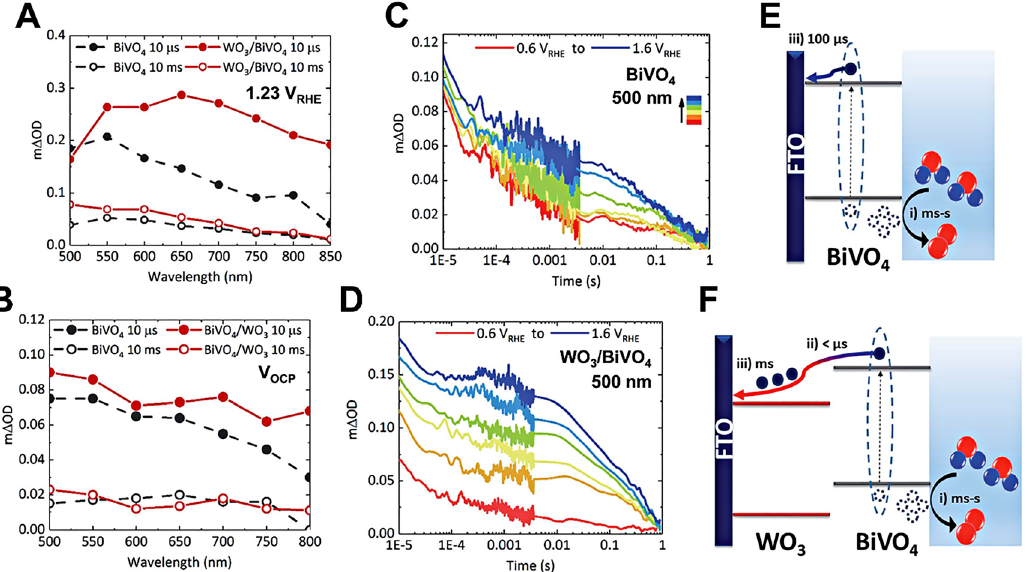
Figure 5: (A, B) In situ transient absorption (TA) spectra of BiVO 4 and WO 3 /BiVO 4 at 1.23 V (A panel) and open-circuit potential (OCP) (B panel) in a 0.1 M phosphate buffer recorded at 10 μ s and 10 ms after UV excitation (355 nm, 500 μ J cm − 2 ). (C, D) TA pro fi les of photoholes (500 nm) of BiVO 4 and WO 3 /BiVO 4 at different applied biases. (E, F) Proposed charge dynamics mechanism of BiVO 4 and WO 3 /BiVO 4 , in which (i) rep- resents water oxidation at the BiVO 4 surface, (ii) denotes the electron transfer from BiVO 4 to WO 3 and (iii) stands for the photoelectron extractionfromthephotoanodetotheexternalcircuit.ReprintedwithpermissionfromastudybySelimetal.[80]Copyright2013RoyalSociety of